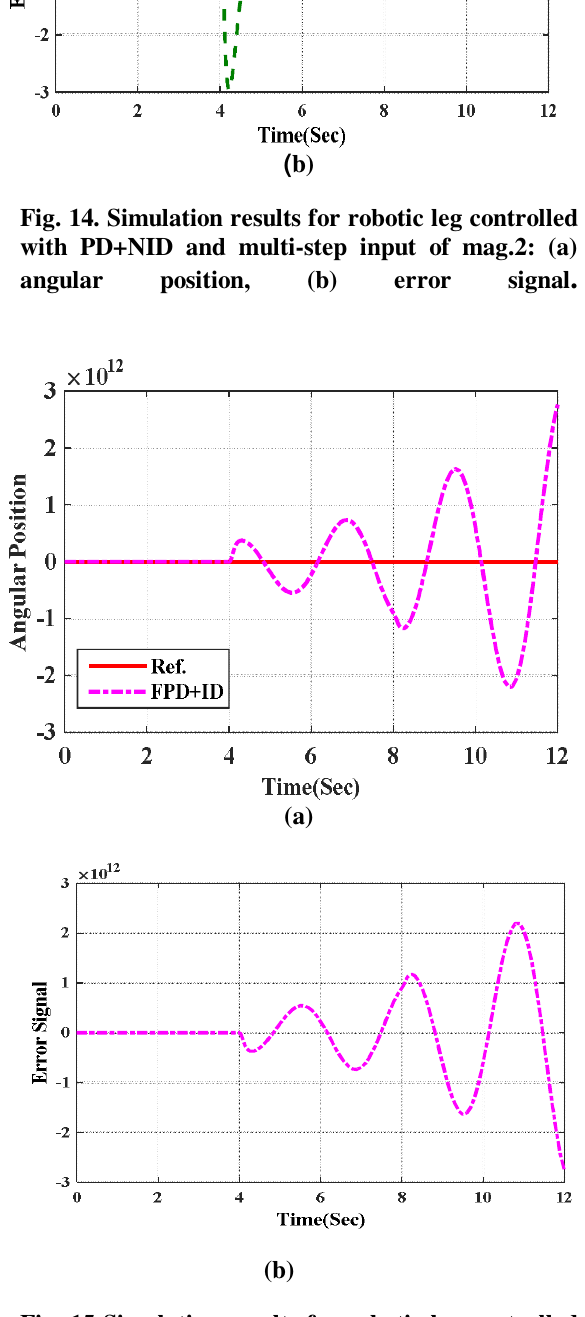
Fig. 15 Simulation results for robotic leg controlled with FPD+ID and multi-step input of mag.2: (a) angular position, error signal.